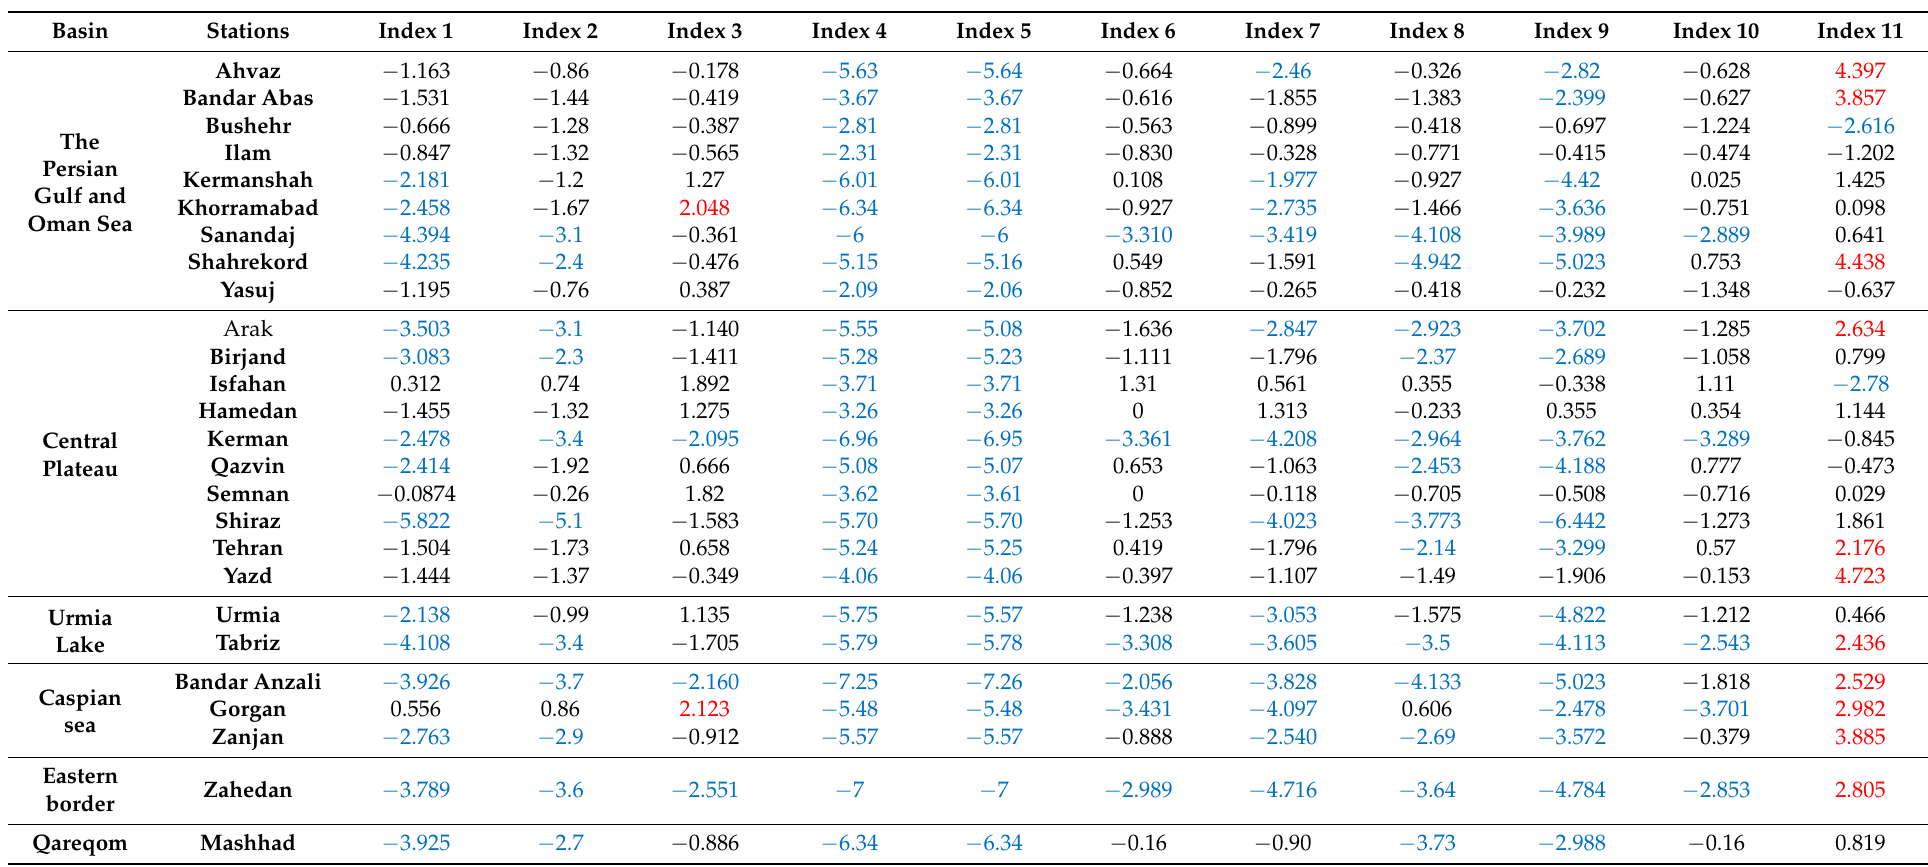
Table 3. Results of the Mann–Kendall test for the studied extreme rainfall indices. Blue and red numbers denote those statistically significant at the 0.05 critical level downward and upward